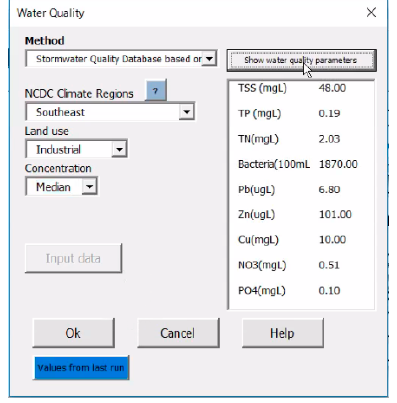
Figure A11. Defining water quality inputs.